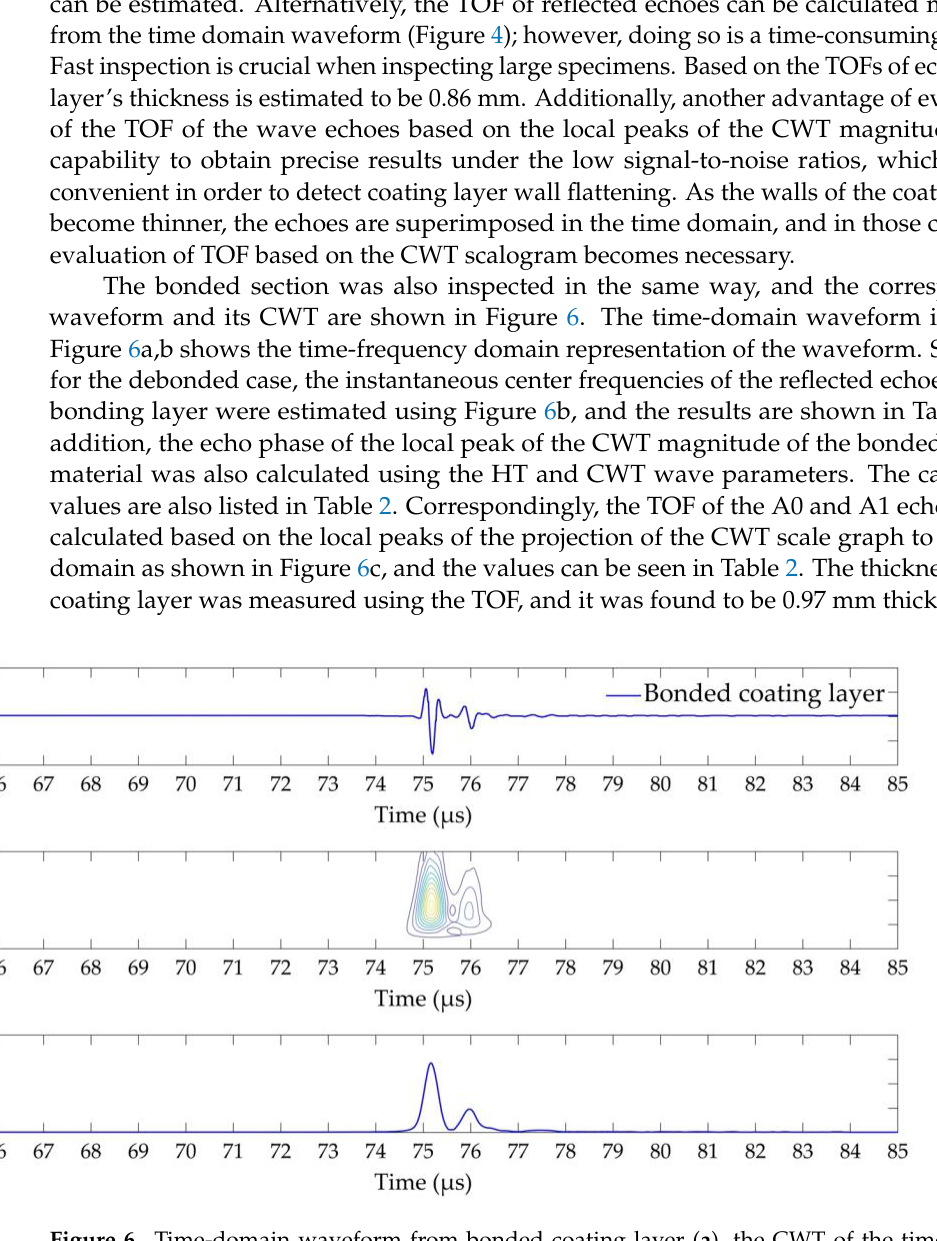
Figure 5. Pulse echo waveform from the debonded coating layer: ( a ) time domain waveform, ( b ) CWT of the waveform, and ( c ) the projection of the CWT magnitude to the time domain.